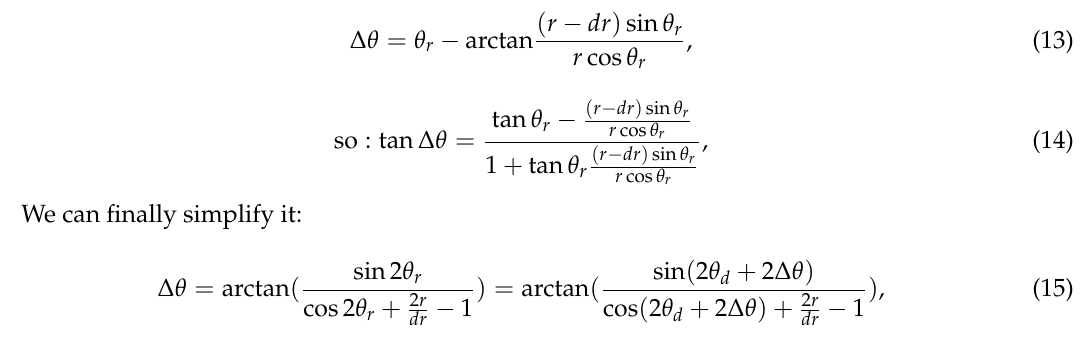
θ . Figure 1. Distribution law of ∆ θ D in one period of θ r . r